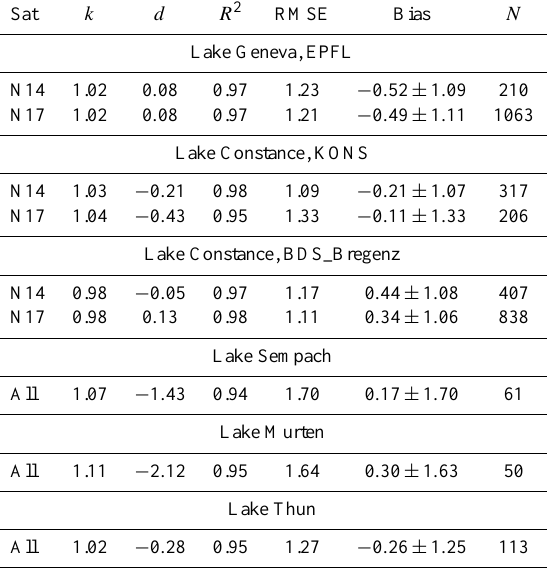
Table 3. Statistical results of the scatter plots in Fig. 5 showing the comparison between in situ observations (OBS) and the regional LSWT-retrieval based on RTTOV-10 (RT-lswt) for various in situ locations (cf. Table 2). Shown are the slope ( k ) and offset ( d ) of the linear regression equation; the coefficient of determination as square of the correlation coefficient ( R 2 ); the root-mean-square er- ror (RMSE); the bias as the mean temperature difference and stan- dard deviation ( (cid:49)T ± σ (cid:49)T ) between OBS and RT-lswt; and the number of coincident observations ( N